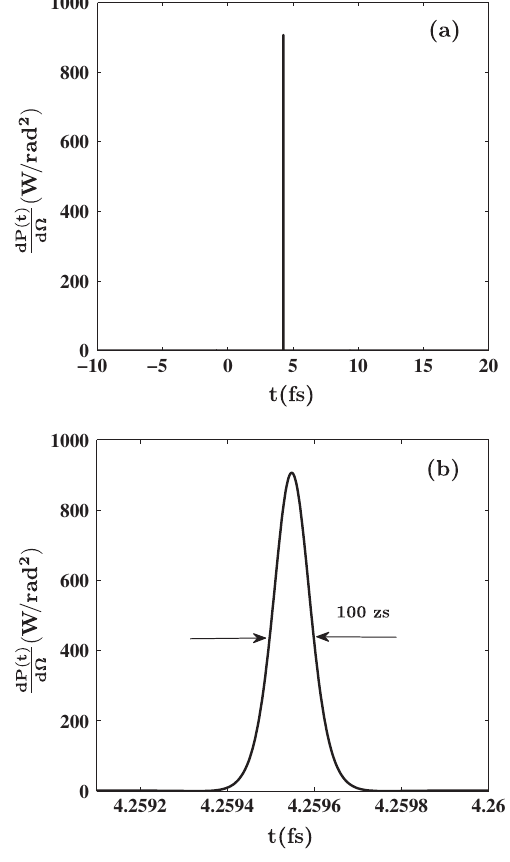
FIG. 2. (a) The time histogram of the radiation power per solid angle along the þ y axis by an electron scattering with a circularly polarized laser pulse. (b) The peak is magnified to show the details of the pulse shape. The parameters taken in the calculations are as follows: the laser pulse propagates along the þ z axis with a 0 ¼ 19 : 57 , N ¼ 3 , (cid:3) 0 ¼ 3 and (cid:2) ¼ 0 , the electron with an initial energy of 5 MeV moves along the þ x axis, and the detection direction ^ n ¼ e y